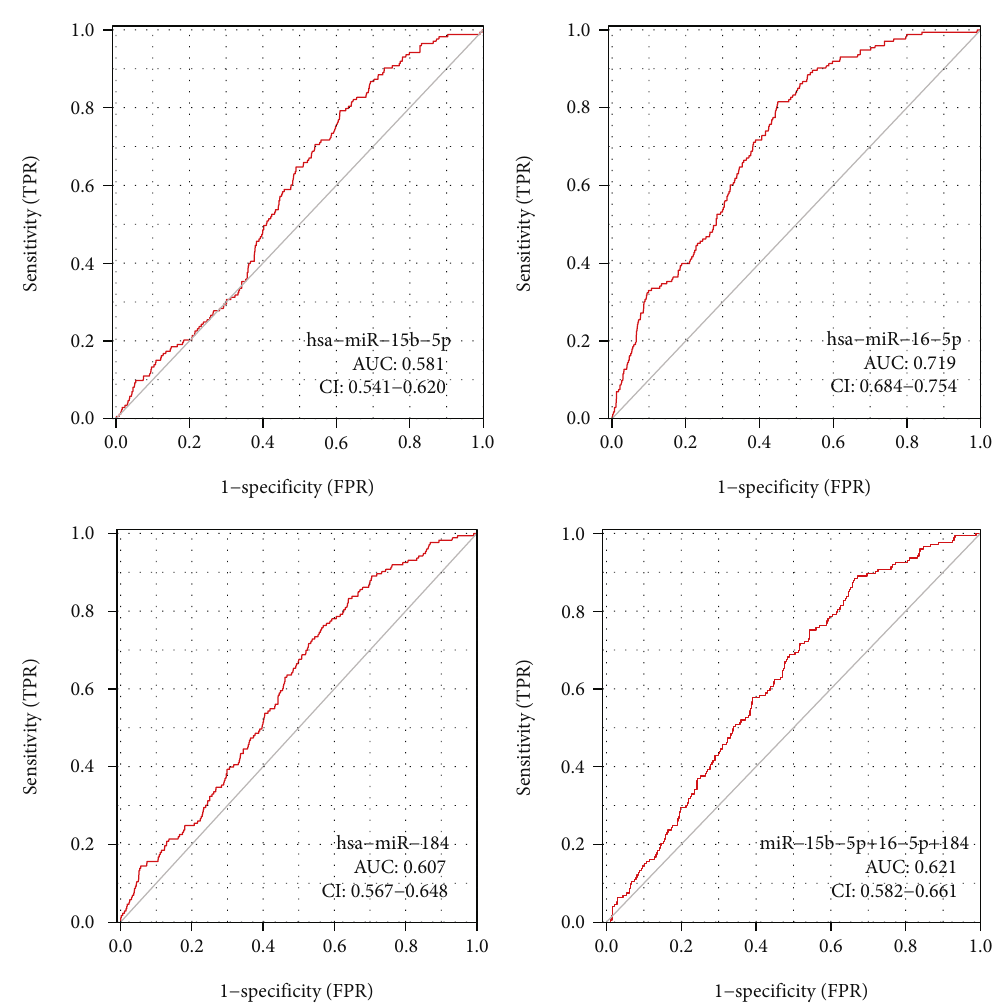
Figure 8: Veri fi cation of the diagnostic e ffi cacy of the key miRNAs. ROC diagnostic curve for the three